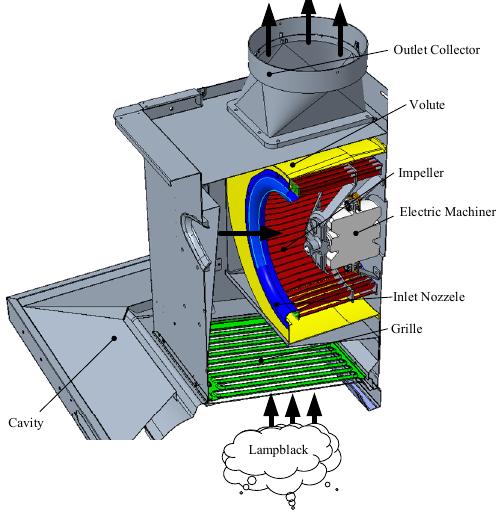
Figure 2. Structure diagram of a range hood. Table 1. Geometrical parameters of the squirrel-cage fan.